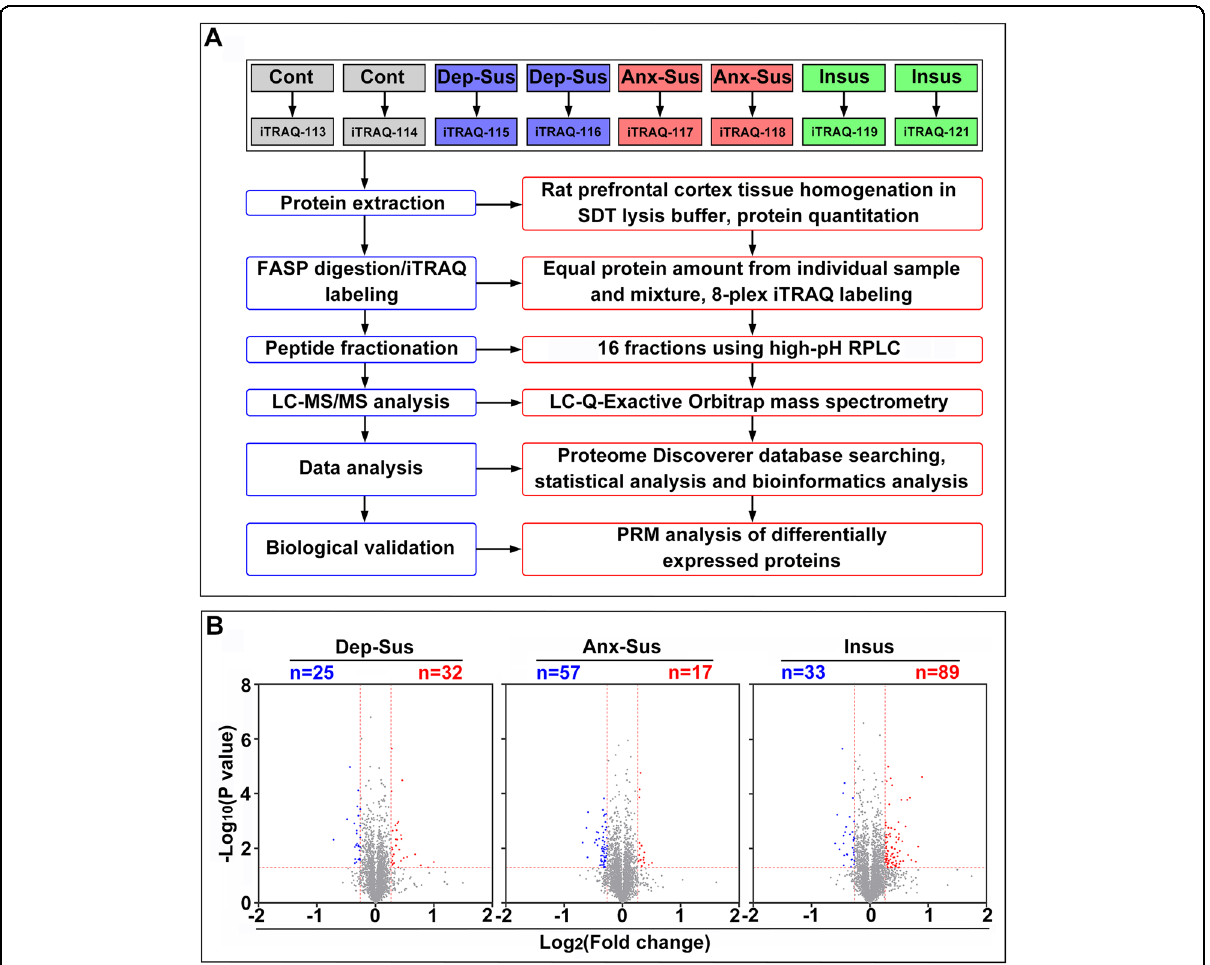
Fig. 1 Comparative pro fi ling of the prefrontal cortical proteomes of the stressed rats. A Analysis fl owchart of isobaric tags for relative and absolute quantitation (iTRAQ)-based quantitative proteomics of the prefrontal cortex tissue samples from the control (Cont), depression-susceptible (Dep-Sus), anxiety-susceptible (Anx-Sus), and insusceptible (Insus) groups. B Identi fi cation of differentially expressed proteins in the prefrontal cortex. Volcano plot displaying protein expression variations in the Dep-Sus, Anx-Sus, and Insus groups. The x -axis shows the average fold change (log2), and the y -axis shows the negative p value (log10). Low and high relative expressions were indicated in blue and red,